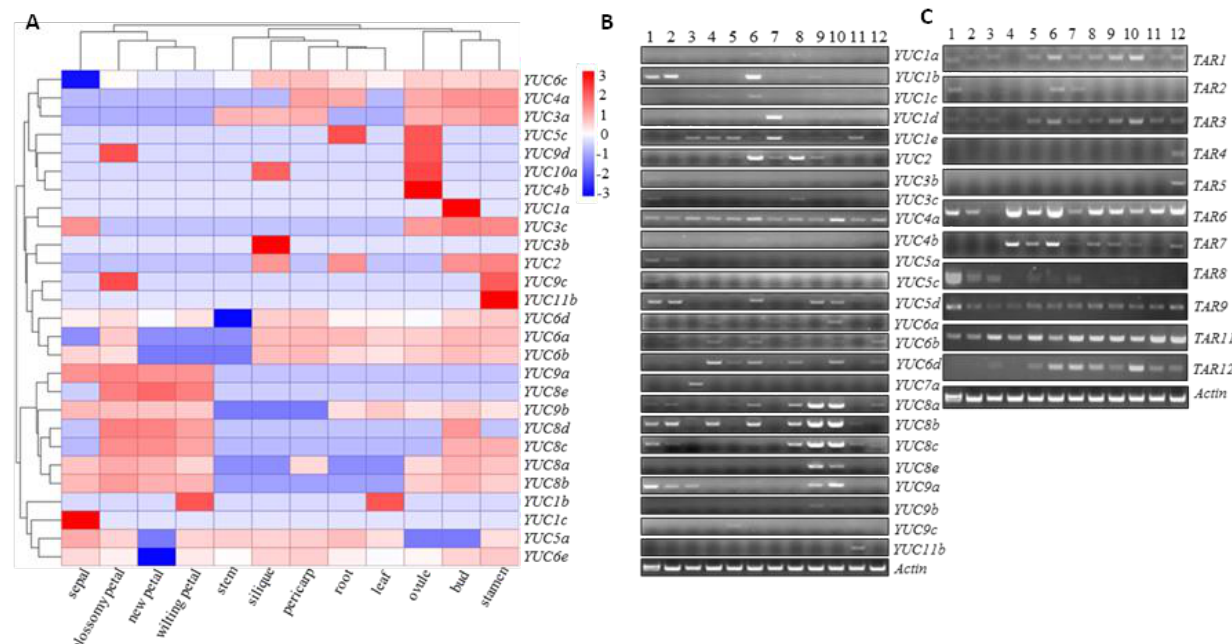
Figure 2. Expression patterns of BnaYUC genes in twelve different tissue samples: ( A ) Tissues used for expression profiling are indicated at the bottom of each column. Color scale bars at the top of map represent log2 transformed FRKM values. Values of 3, 0 and -3 represent positive, zero and negative expression, respectively. The genes are on the right of the expression bar. ( B , C ) Tissue expression pattern validated by RT-PCR. Tissues used for expression profiling are indicated at the top of each column. 1, young root; 2, hypocotyl; 3, cotyledons; 4, stem; 5, leaf; 6, small bud; 7, big bud; 8, pistil; 9, stamen; 10, petal; 11, flower stalk; 12, silique. Genes are on the left of expression bar. Actin gene was amplified with 27 cycles. Other genes were amplified with 35 cycles.